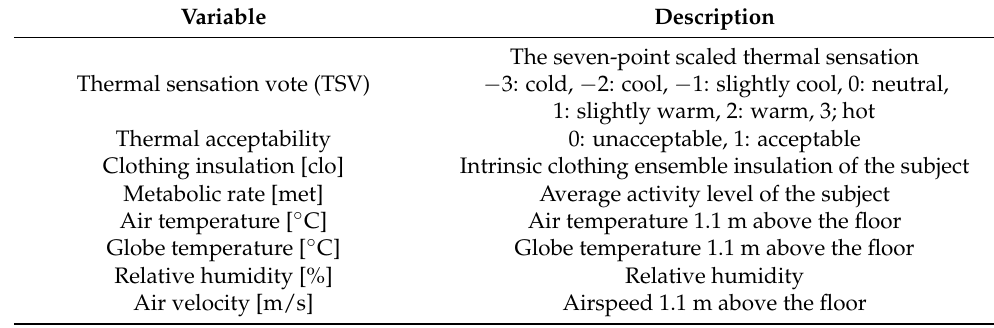
Table 1. Dataset